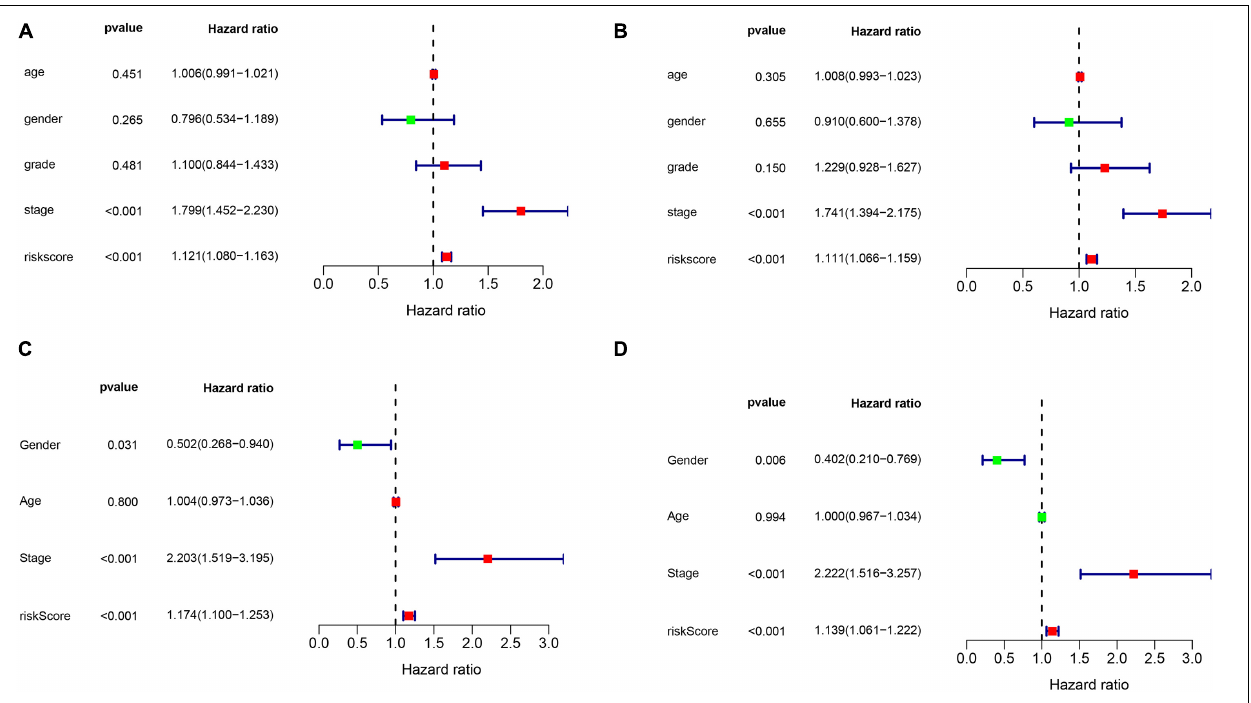
FIGURE 4 | The independence identification of the risk model. Univariate cox regression analysis and multivariate cox regression analysis was performed in the TCGA dataset (A,B) and ICGC dataset (C,D) , respectively.